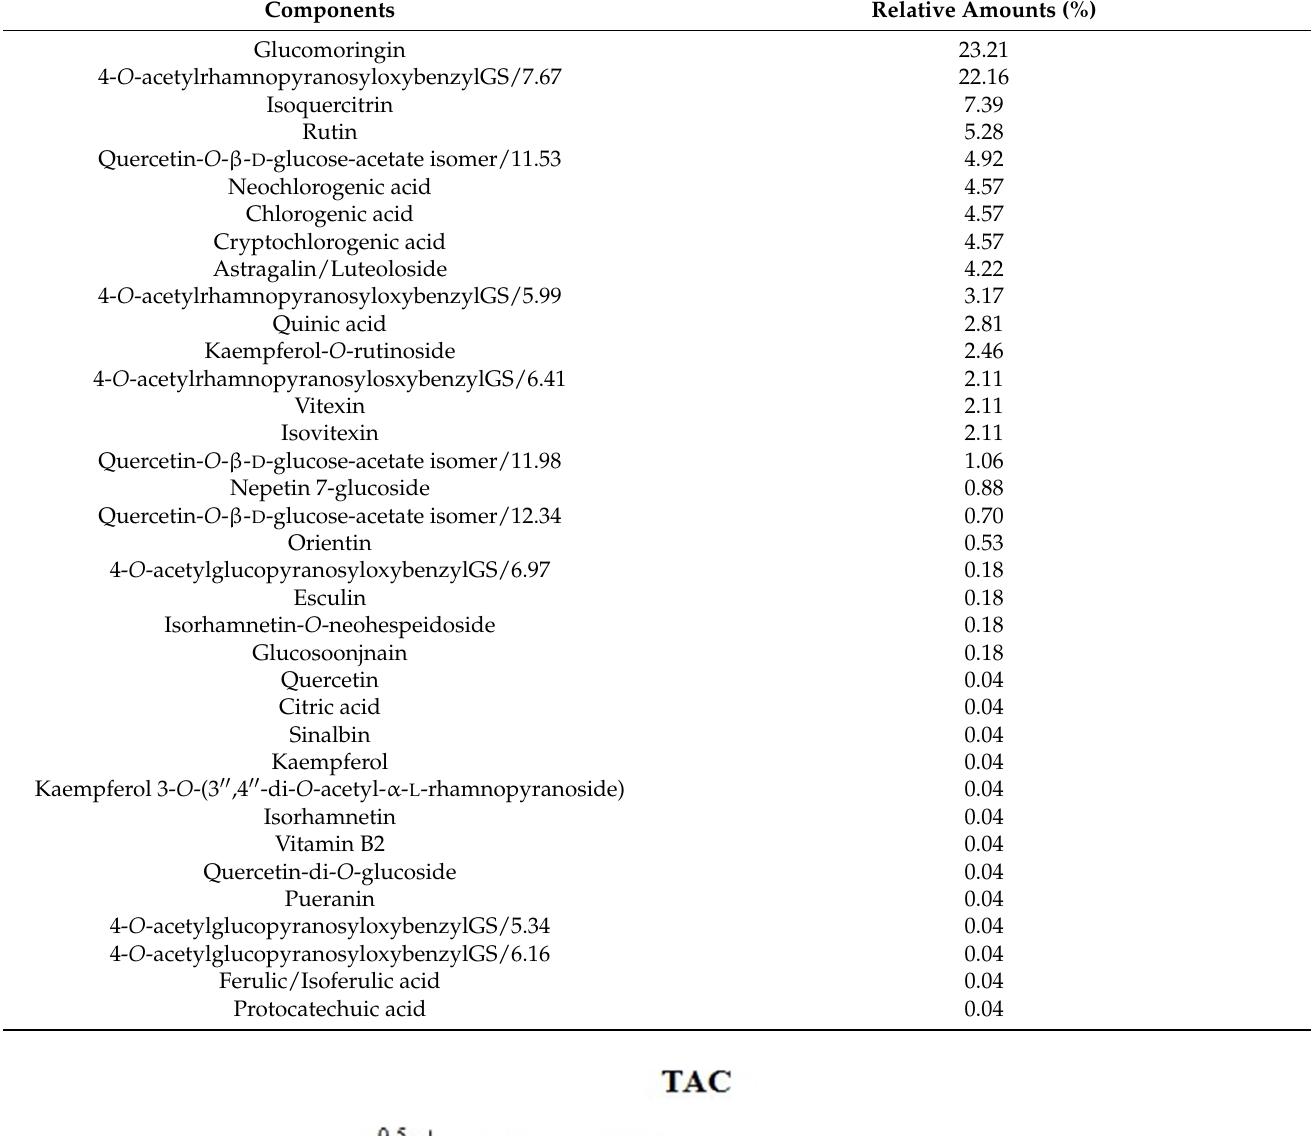
Table 1. Relative amounts of constituents in MOLE samples.